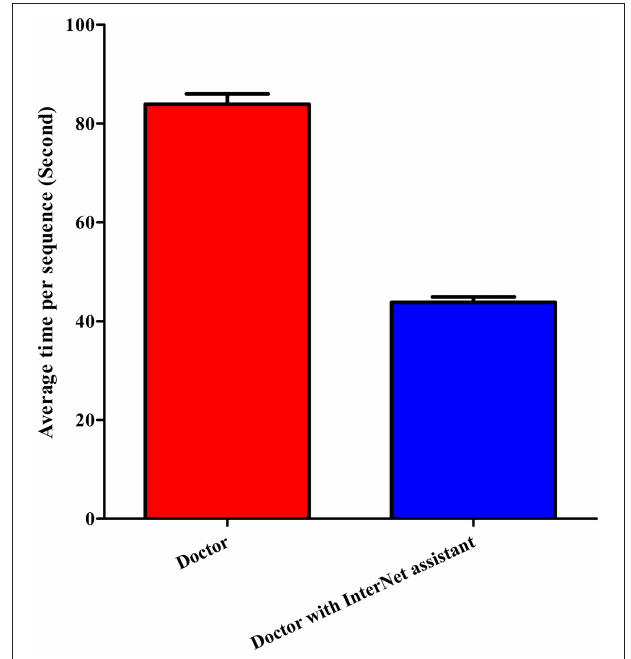
FIGURE 4 | Receiver operating characteristic (ROC) curve for doctor without and doctor with InterNet assistant. Doctor with InterNet assistant showed a superior performance to that of doctor without InterNet assistant. The AUCs of doctor with and doctor without InterNet were 0.803 and 0.759, respectively.